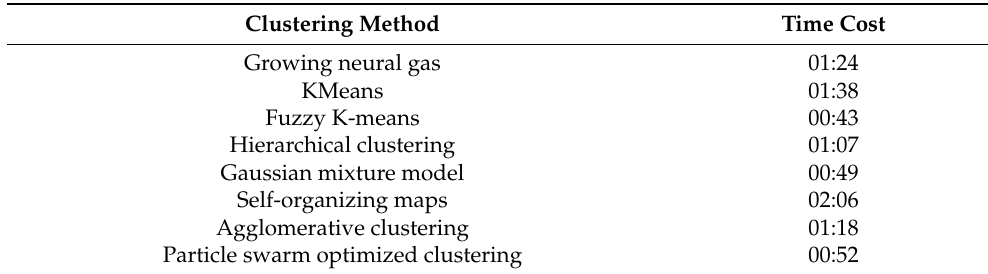
Table 1. Time consumed (mm:ss) in executing the feature extraction workflow with the specified clustering methods tested on the sequence 0001 from the Kitti data set